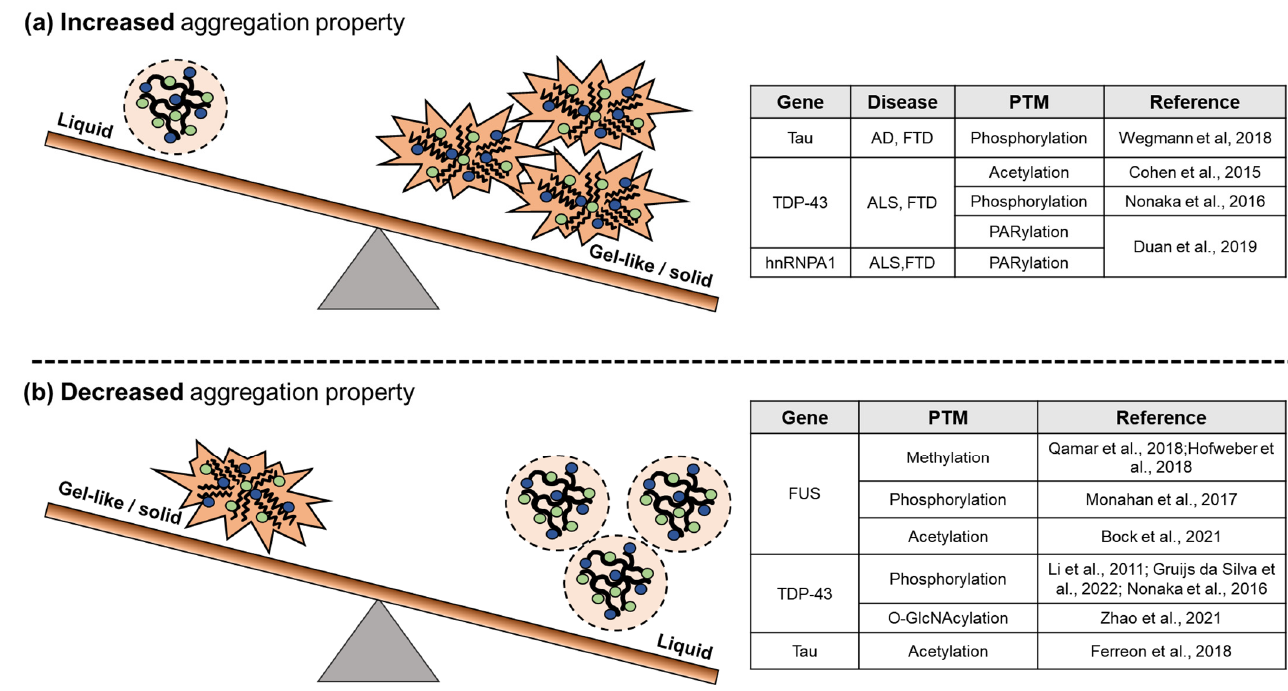
Figure 3. PTMs on pathological RNP granules. ( a ) Increased aggregation property by PTMs on RBPs: phosphorylation of tau [114] or TDP-43 [121], acetylation of TDP-43 [122], PARylation of TDP-43, or hnRNPA1 [103] accelerate the solid transition. ( b ) Decreased aggregation property by PTMs on RBPs: methylation [85, 116], phosphorylation [119], or acetylation [120] of FUS; phosphorylation [117, 118, 122], or acetylation of tau [115] prevent the phase to solid transition.